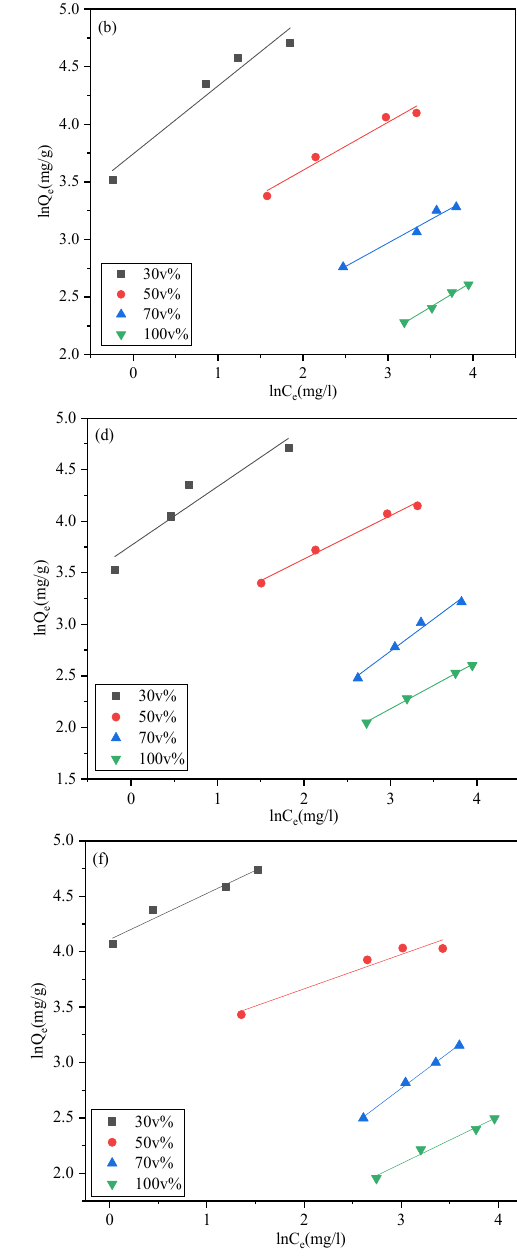
Figure 3. Adsorption isotherm models: ( a , c , e ) 20 °C, 30 °C, and 40 °C Langmuir adsorption isotherm equations; ( b , d , f ) 20 °C, 30 °C, and 40 °C Freundlich adsorption isotherm equations.